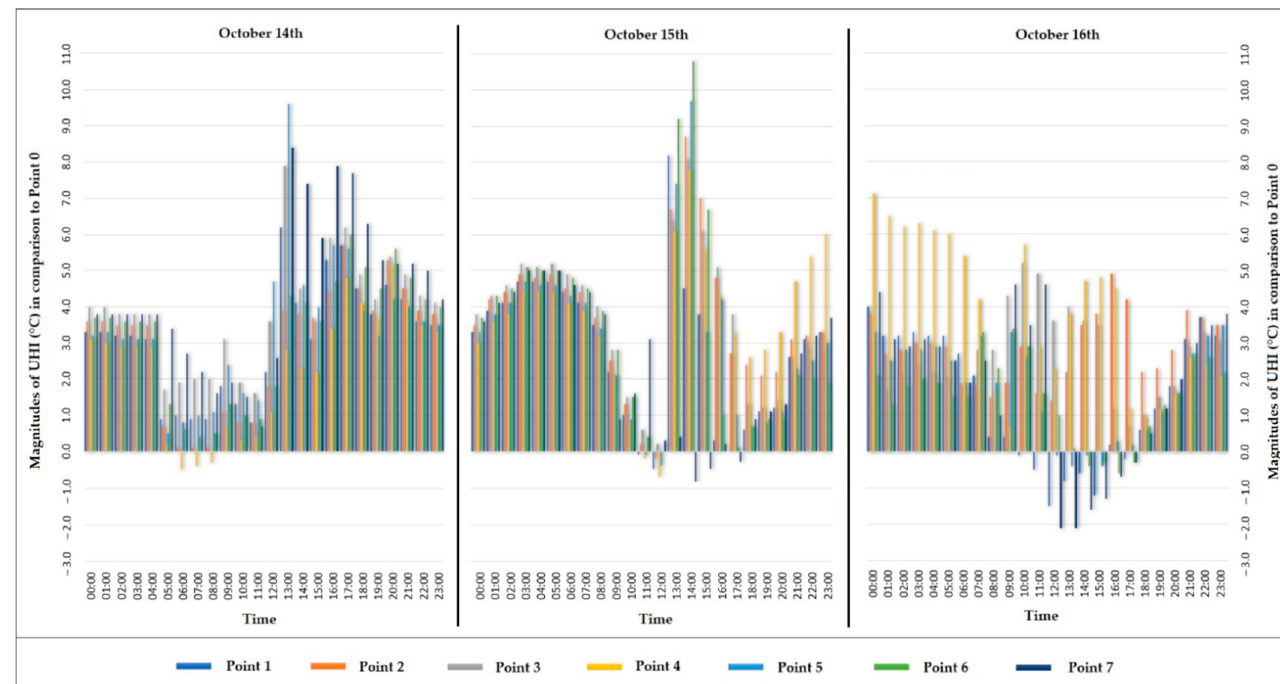
Figure 10. Hourly magnitude of the Ta and UHI of the seven points in Balneário Camboriú